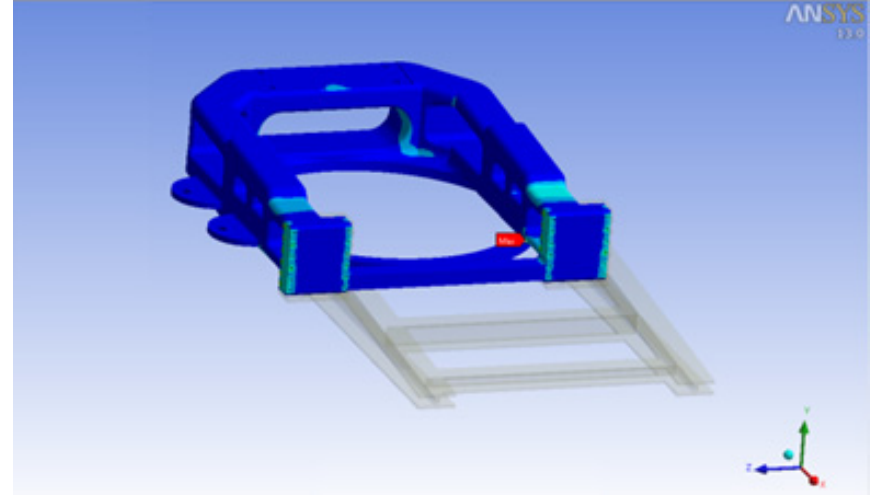
Figure 12. Minimum stress on the cast part [30] .